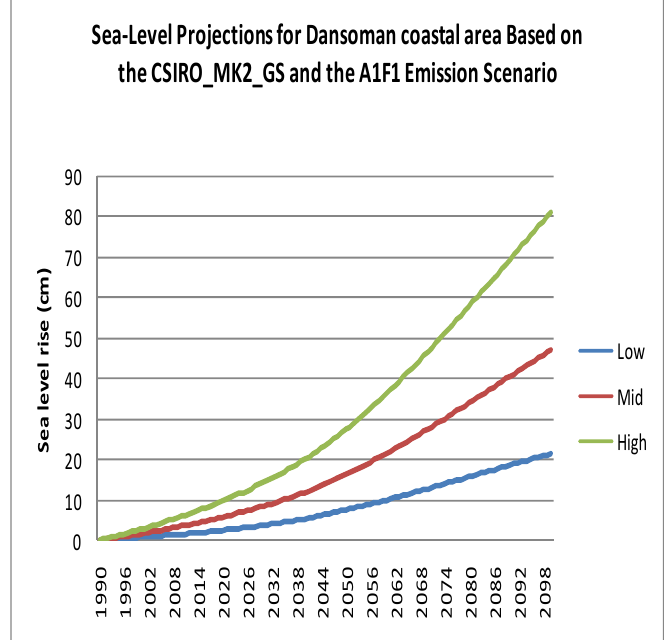
Figure 2. Sea Level Rise Projections based on CSIRO_MK2_GS